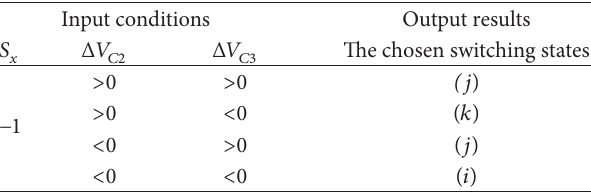
Table 6: Control table for capacitor voltage: 𝑆 𝑥 = −1 .